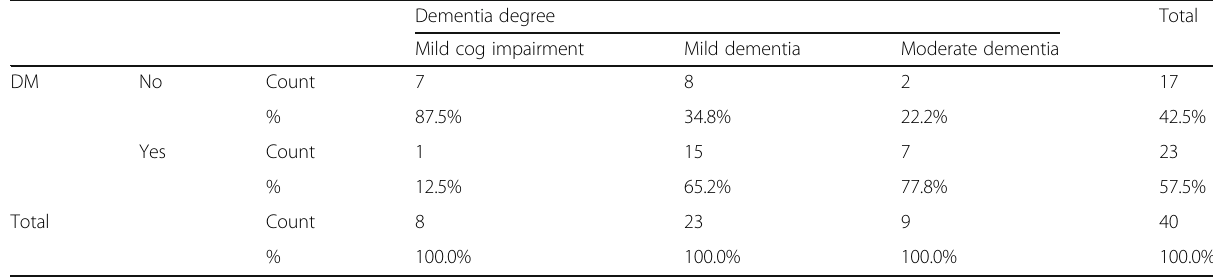
Table 7 Distribution of the degree of dementia according to the history of DM Dementia